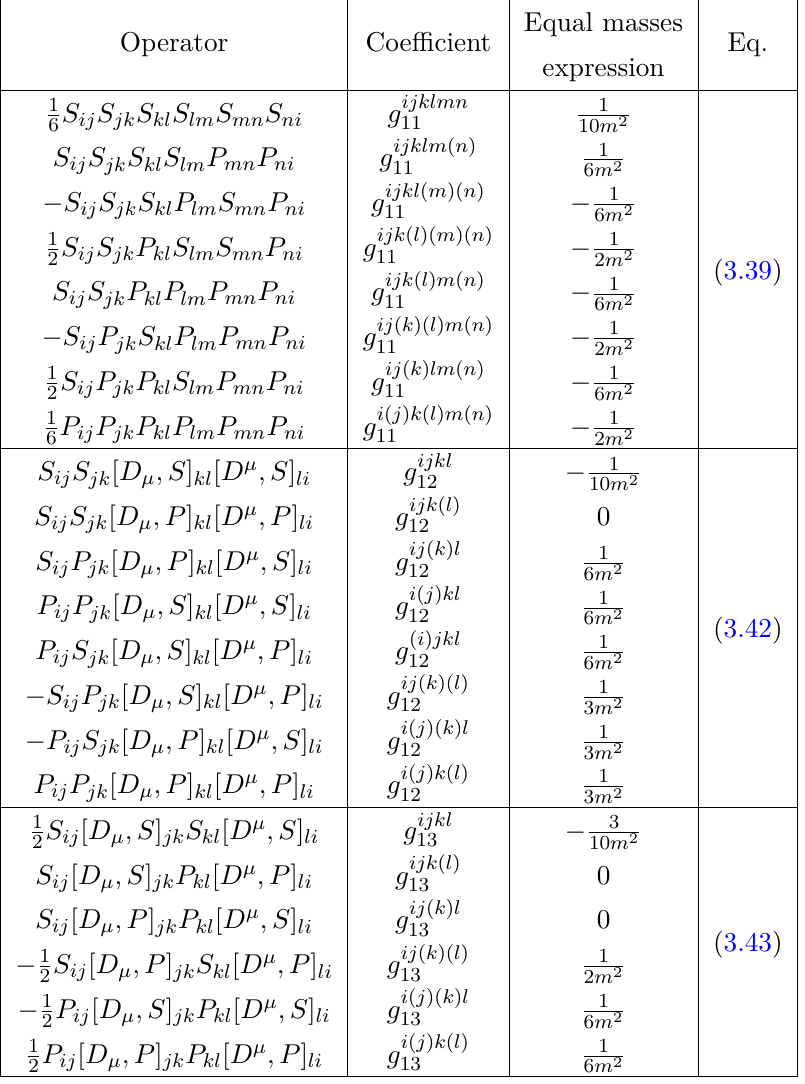
Table 3 . Values of the O ( X 6 ) and O ( X 4 D 2 ) fermionic universal coefficients in the limit of equal